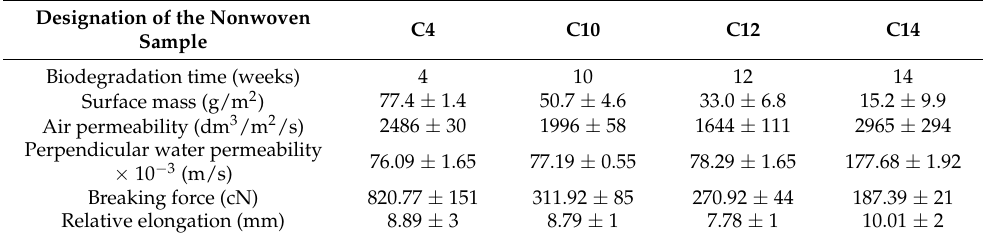
Table 4. Physicochemical parameters of nonwoven C during biodegradation studies. Designation of the Nonwoven